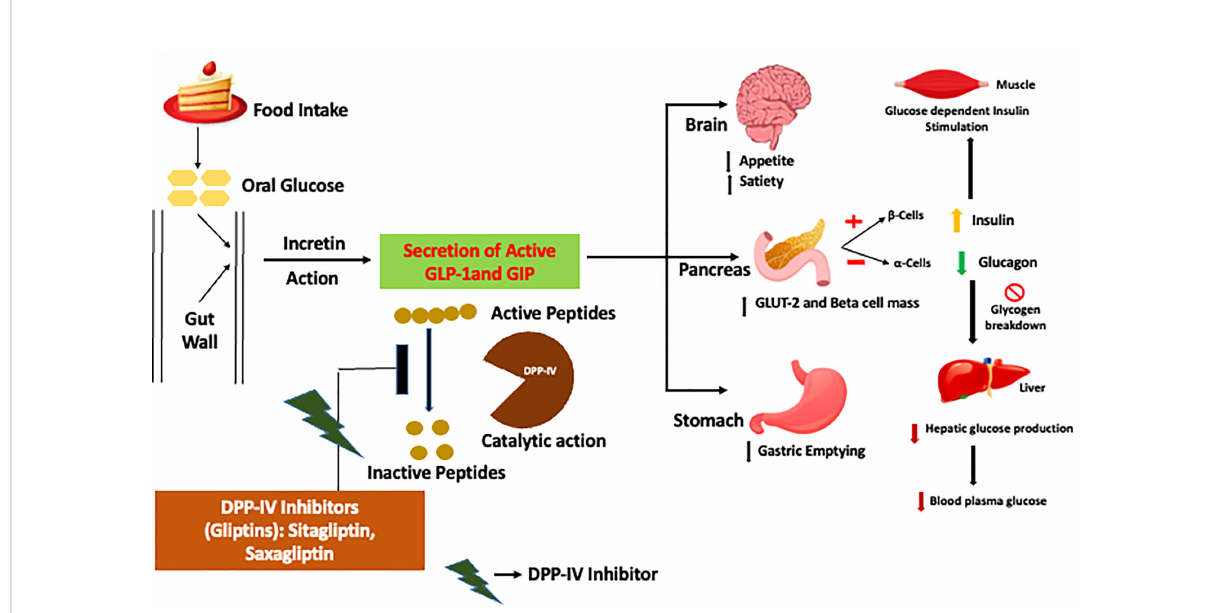
FIGURE 2 Model of the mode of action of dipeptidyl peptidase (DPP)-IV inhibitors for augmenting incretin activity. In healthy individuals, food intake aids the secretion of incretin hormones from the alimentary canal, which further favors the synthesis and release of insulin and additionally arrests the synthesis and release of glucagon, subsequently maintaining the glucose levels in blood plasma. However, type 2 diabetes mellitus patients incur a loss of incretin activity by the catalytic action of the DPP-IV enzyme, which is abated by DPP-IV inhibitors in order to escalate the incretin levels for regulating glucose homeostasis.